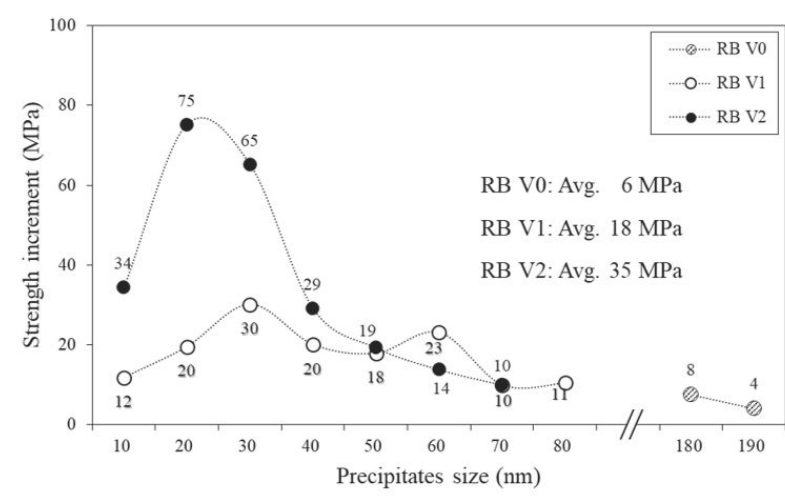
Figure 7. Increase in yield by precipitation hardening for various V contents.